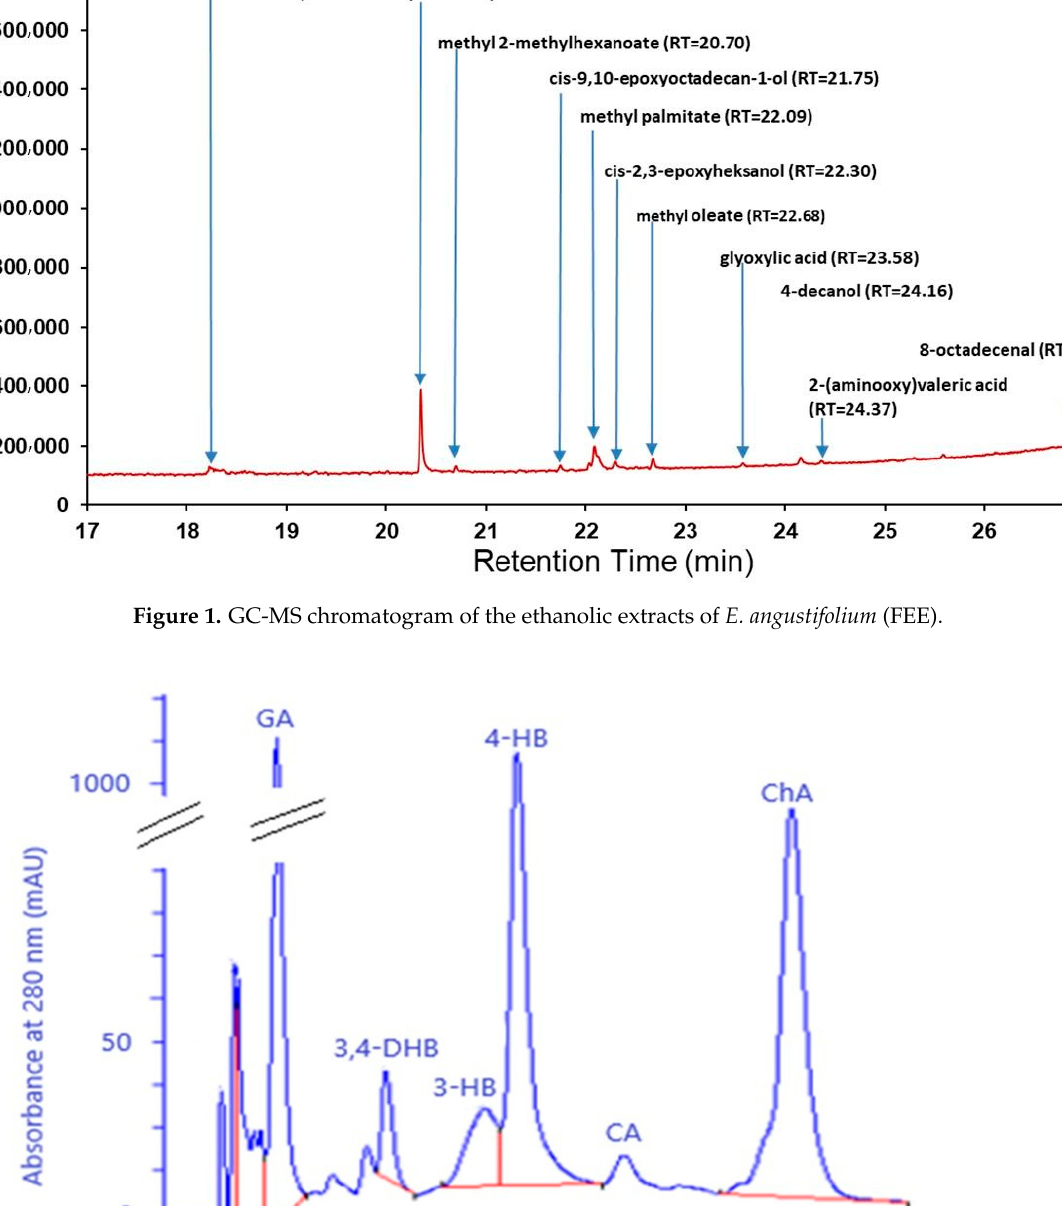
Figure 2. Chromatogram of phenolic acid identified in the ethanol extracts from E. angustifolium (FEE): GA—gallic acid; 3,4-DHB—3,4-dihydroxybenzoic acid, 4-HB—4-hydroxybenzoic acid, 3-HB—3-hydroxybenzoic acid, ChA—chlorogenic acid, and CA—caffeic acid.